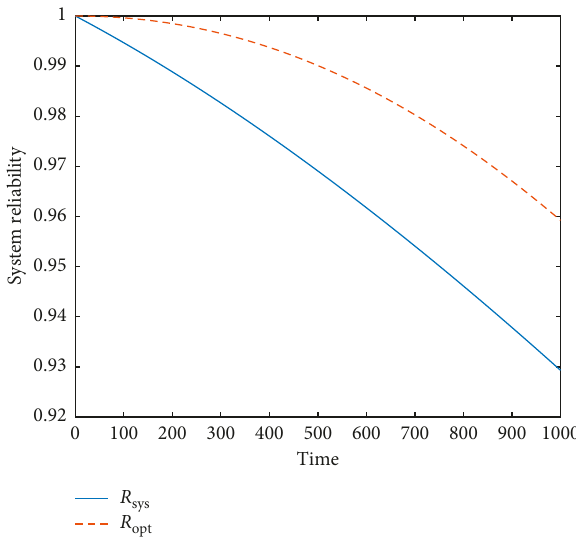
Figure 11: System reliability curves (Example 1).